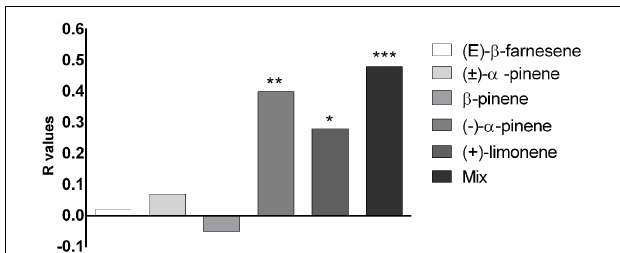
FIGURE 6 | Behavioral responses of M. viciae to the main compounds identified in the insect’s cornicle secretions and to the mixture containing (E)- β -farnesene 14.2%, (–)- α -pinene 11.8%, β -pinene 74%. The repellency index R was calculated by the formula R = (C–T)/(C+T), where T indicates the number of aphids in the arm with the compound to be tested and C, those in the control arm. Asterisks indicate that the repellence observed is significantly different from the control ( ∗ p < 0.05, ∗∗ p < 0.01, ∗∗∗ p < 0.001,